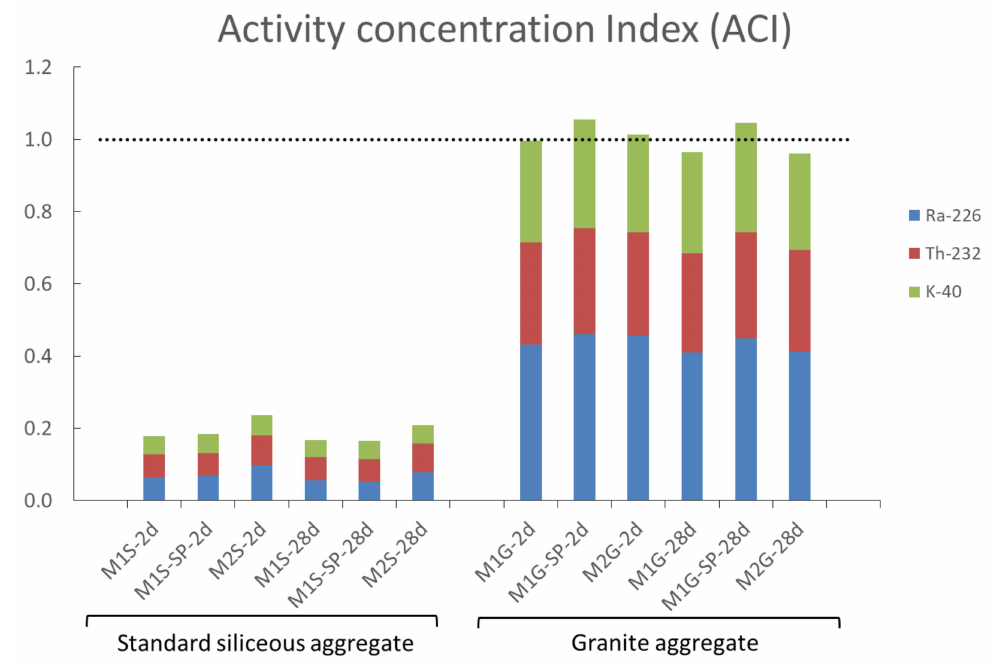
Figure 4. Activity concentration for cubic of OPC-FA and hybrid cement mortars prepared with standard siliceous or granite